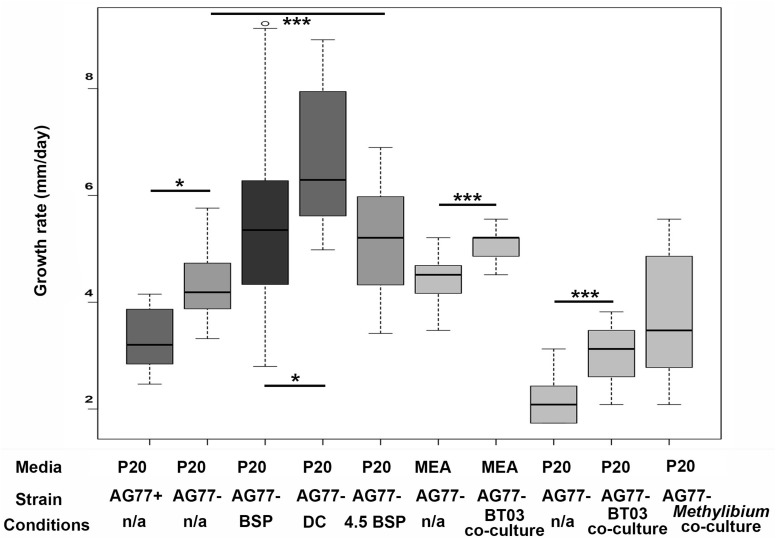
Fungal growth rates of M. elongata in response to conditioned media from microfluidic and plate based growth assays. All values extrapolated to units of millimeters growth per day. Growth data from microfluidic device data are indicated in gray scale boxes on the left (see Table 3). AG77+/– refer to endosymbiont presence and absence used in device validation. BSP media was conditioned with bacterial growth, DC media was conditioned with successive fungal then bacterial growth, and pH 4.5 BSP media was buffered at pH.5 and conditioned by bacterial growth. Data from plates are in lighter gray boxes on the right and are coded by media type. ∗p ≤ 0.05, ∗∗∗p ≤ 0.001.